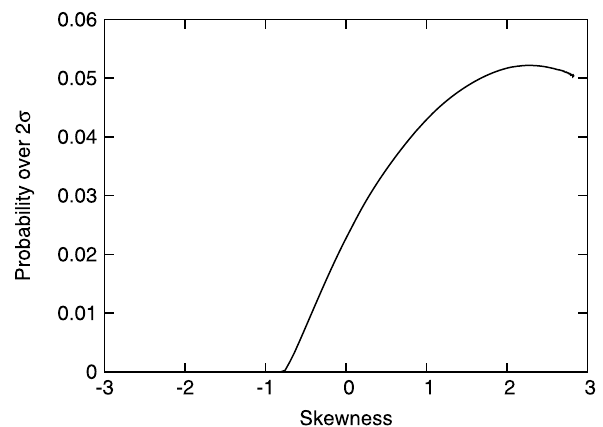
Fig. 2. Relationship between skewness and probability over 2 s .